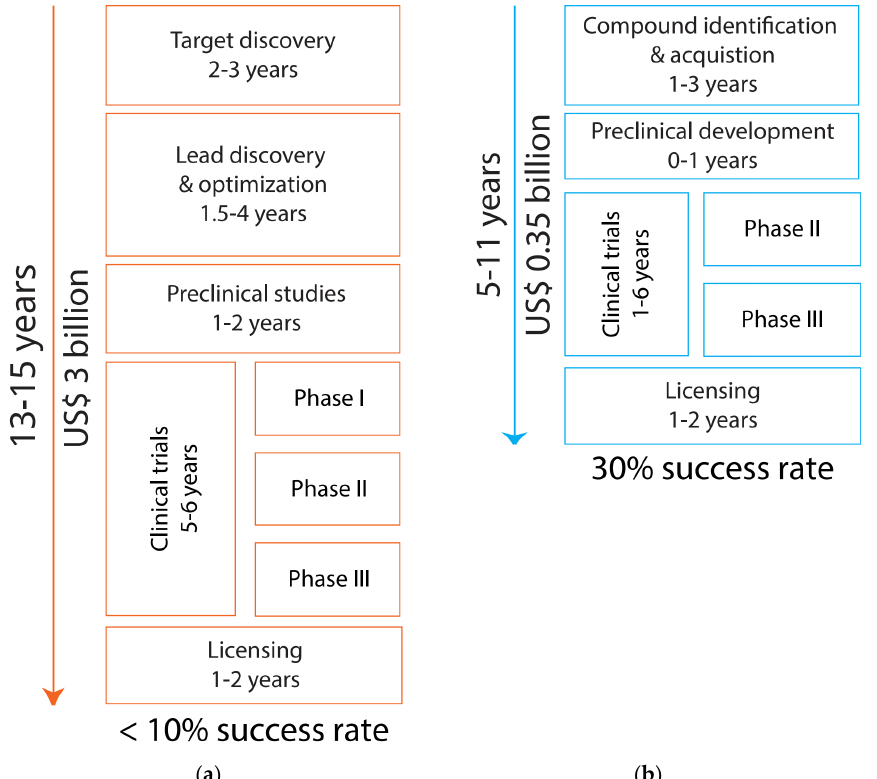
Figure 1. The comparison between (a) conventional drug discovery and (b) drug repurposing. ( a ) De novo drug discovery usually requires 13–15 years and may cost up to USD 3 billion from